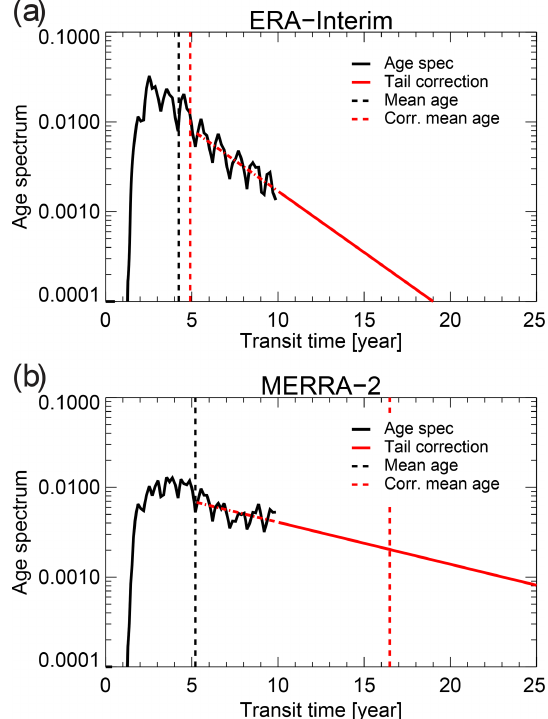
Figure 12. (a) Age spectrum at 46 ◦ N and 700K potential tem- perature for June 1992 from ERA-Interim (a) and MERRA-2 (b) . Red lines illustrate the correction method for the finite age spec- trum tail by fitting an exponential function to the tail at transit times older than 5 years (see Sect. 2). The dashed red vertical line shows the mean age for the tail-corrected spectrum, the dashed black line shows the mean age for the uncorrected case. (Note the logarithmic y axis, varying over 3 orders of